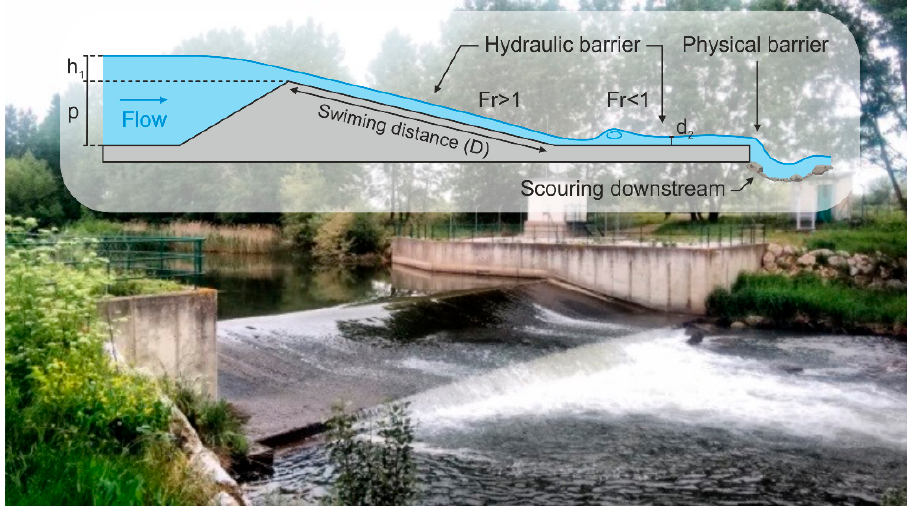
Figure 2. Gauging station with a flat-V weir with scouring problems (Carrión River, Villoldo, Palencia), together with a sketch showing the main problems for the fish ascent. Fr stands for Froude number. See Figure 1 for variable description.